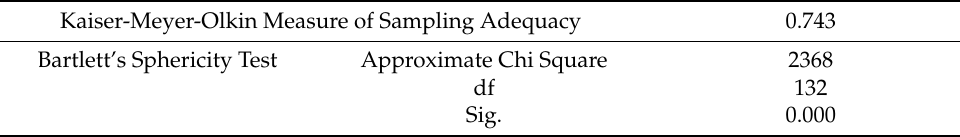
Table 4. KMO value and Bartlett’s Sphericity of Electric vehicle Purchase